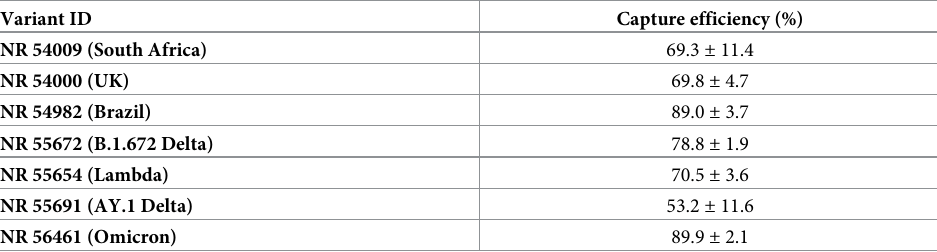
Table 2. Average column capture efficiency for SARS-CoV-2